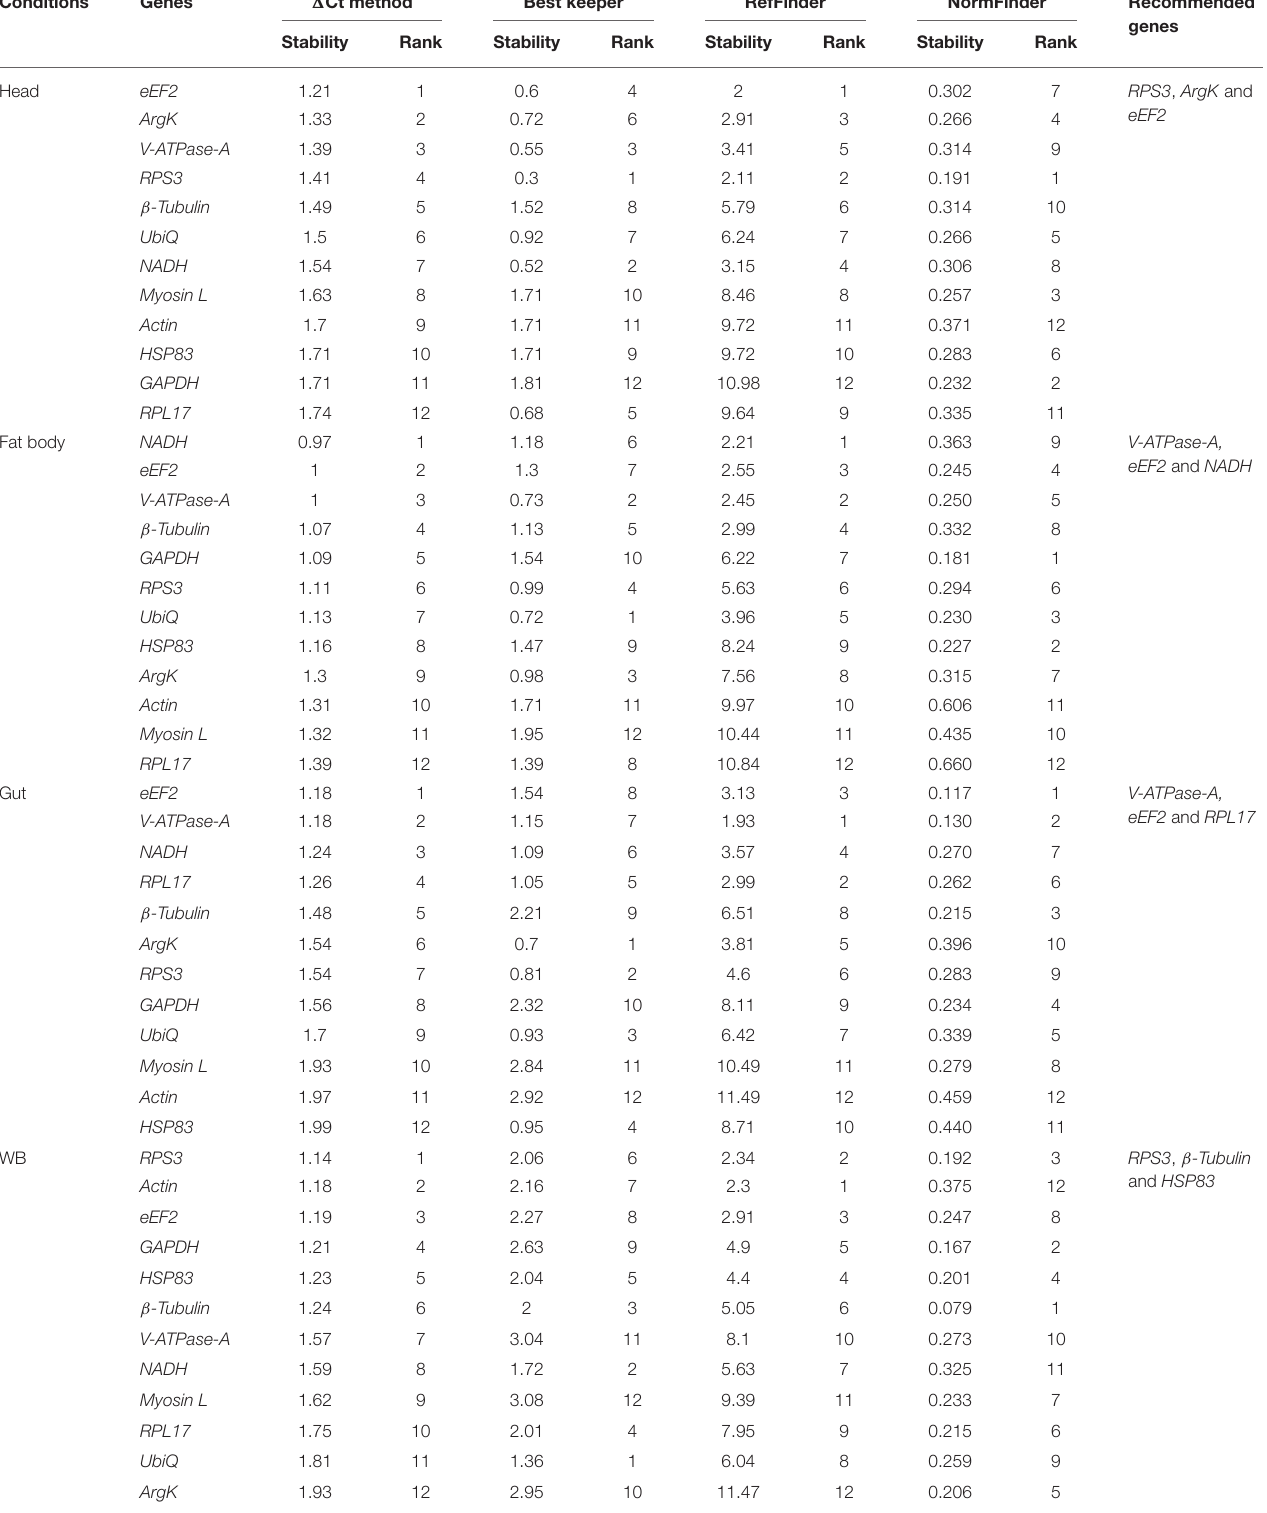
TABLE 4 | Ranking of the candidate reference genes based on stability values performed by Delta Ct, BestKeeper, RefFinder, and NormFinder in various tissue types [head, midgut, fat body, and whole body (WB) except head, gut, and fat body (Abdomen)]. Conditions Genes